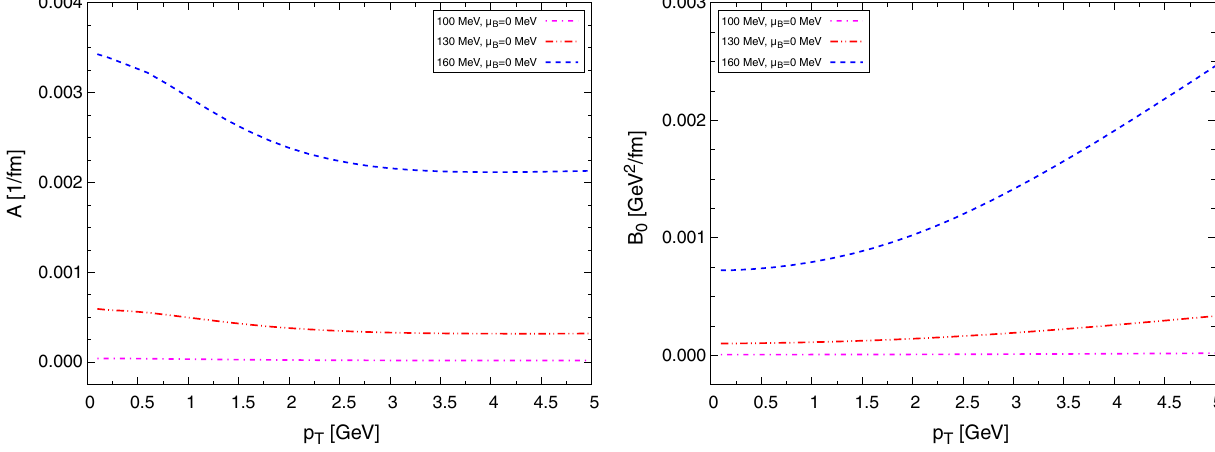
Fig. 5 Drag (left) and diffusion (right) coefficients at different temperatures for ¯ D mesons interacting with baryons N and